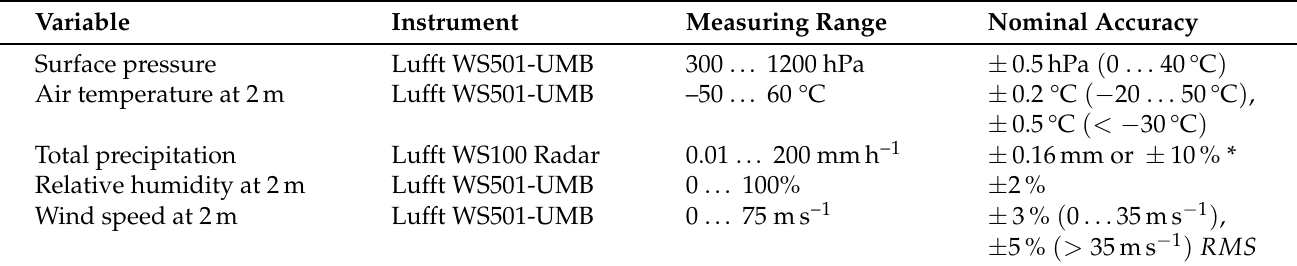
Table 1. Variables, instruments, measuring range and nominal accuracies of the automatic weather station located at 5359ma.s.l. in the direct vicinity of Halji glacier. The full name of the instruments are Lufft WS501-UMB Smart Weather Sensor and Lufft WS100 Radar Precipitation